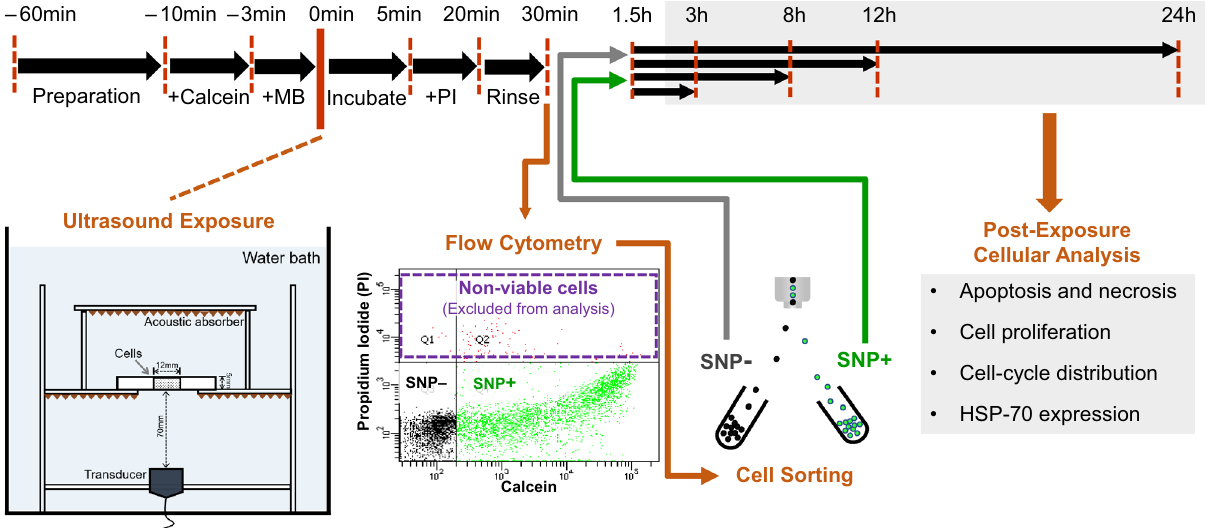
Figure 1. Experimental protocol for investigating the downstream cellular impact of sonoporation. A calibrated acoustic exposure platform was used to deliver ultrasound pulses to cell samples at 0 min. Fluorescence activated cell sorting (FACS) was then performed to isolate sonoporated cells (SNP+ group) and unsonoporated cells (SNP– group). The development trends of each sorted cell group were then assayed at different post- exposure time points over a 24 h